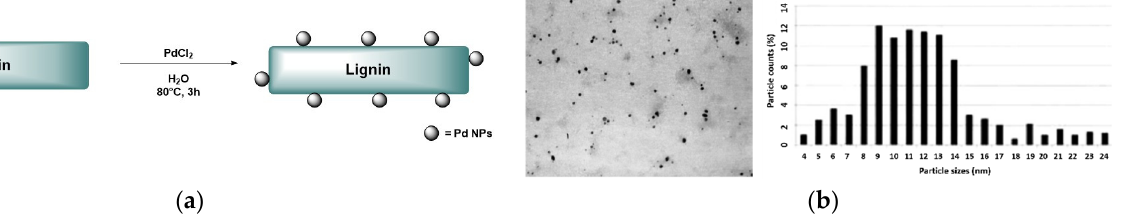
Figure 20. ( a ) Preparation of palladium NPs by using lignin as reductant; ( b ) TEM image of Pd NPs on Kraft lignin and their size distribution